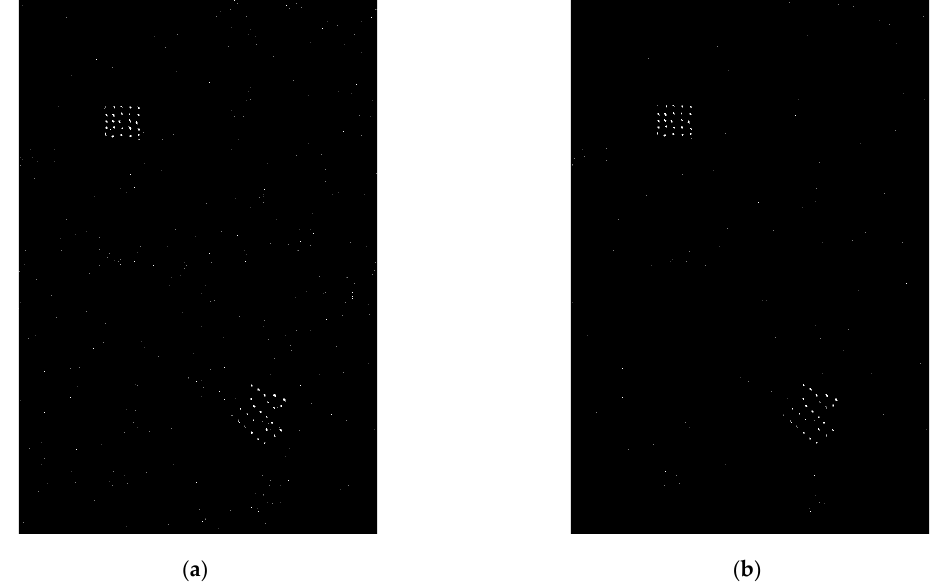
Figure 6. Constant false alarm rate (CFAR) detection results for the image pair shown in Figure 2: ( a ) detection results based on GG model; ( b ) detection results based on proposed model.